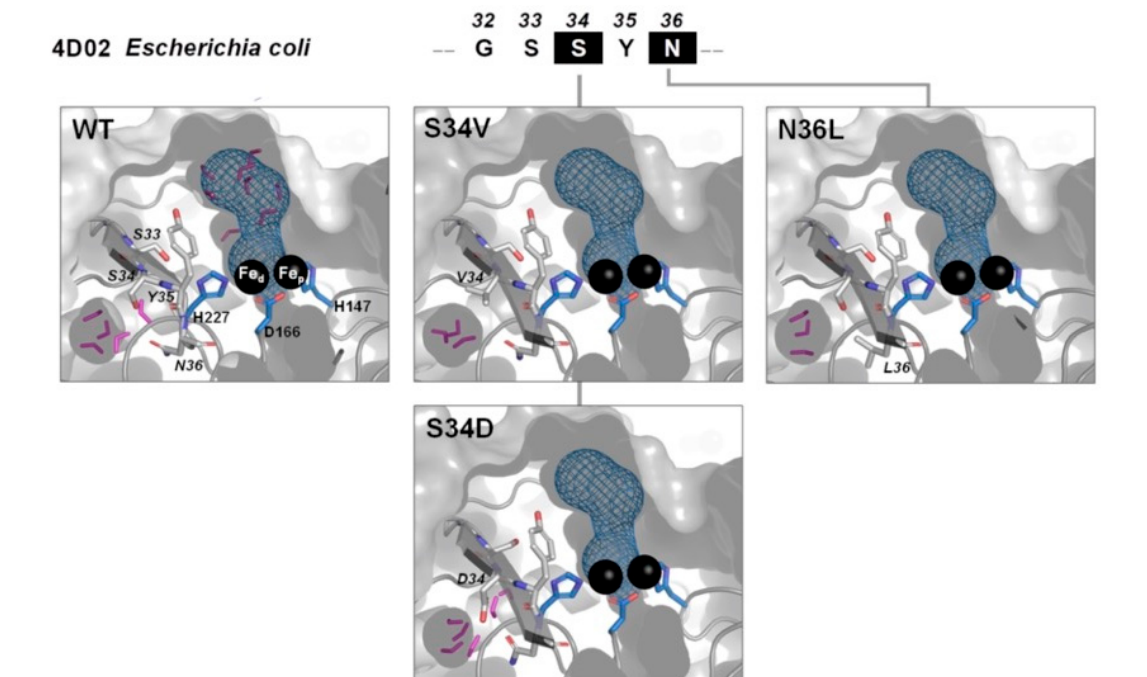
Figure 7. Homology-based models of the S34V, S34D and N36L FDP mutants. The figure was built with PyMOL using the X-ray structure for the wt protein (PDB code: 4D02) and the structures corresponding to the best models generated for the mutants; the small channel is represented as blue mesh determined using MOLE [28]. The protein’s secondary structure elements are shown using a gray cartoon representation and the molecular surface is also represented in gray. For simplicity, only some residues coordinating the metal center, His227, Asp166 and His147, are displayed, using sticks with the carbons colored in blue and the iron atoms represented as black spheres, labeled as proximal Fe (Fe p ) and distal Fe (Fe d ). The water molecules predicted by Dowser++ [32] are depicted as pink sticks.